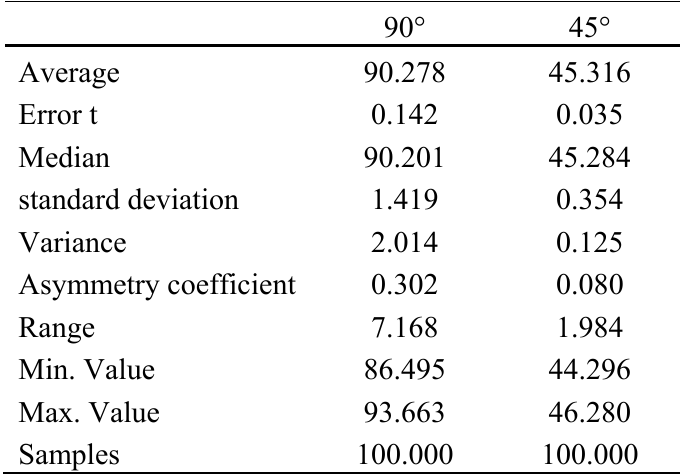
Table 1. Statistical data for 45º and 90º measurement